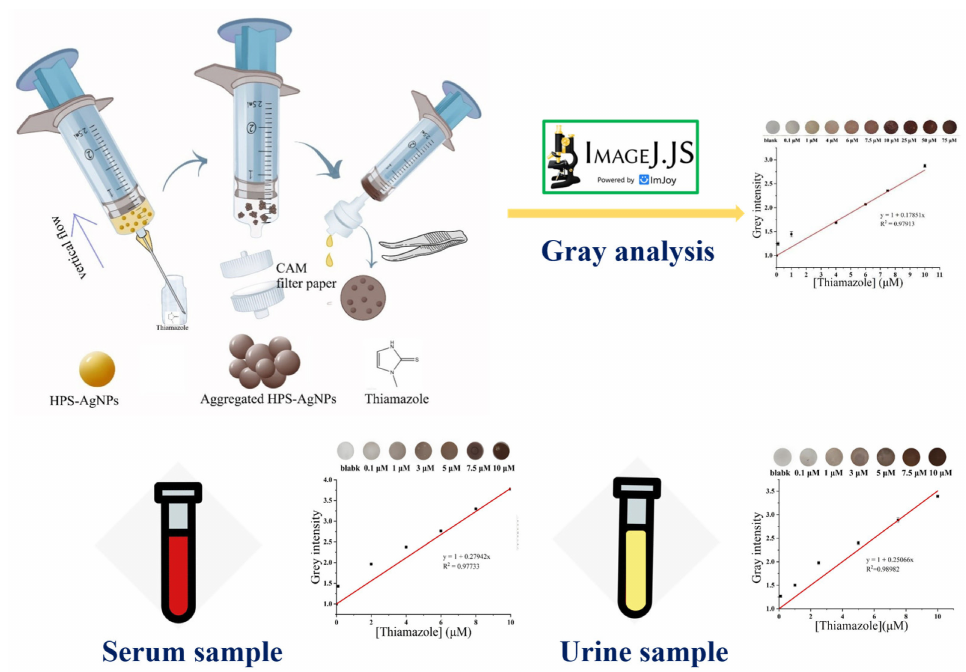
Figure 4. ( A ) The photograph and UV-vis spectra of the HPS-AgNP detection results of methimazole. ( B ) The results and linear diagram of the detection results of thiamazole by the syringe paper-based detection device.